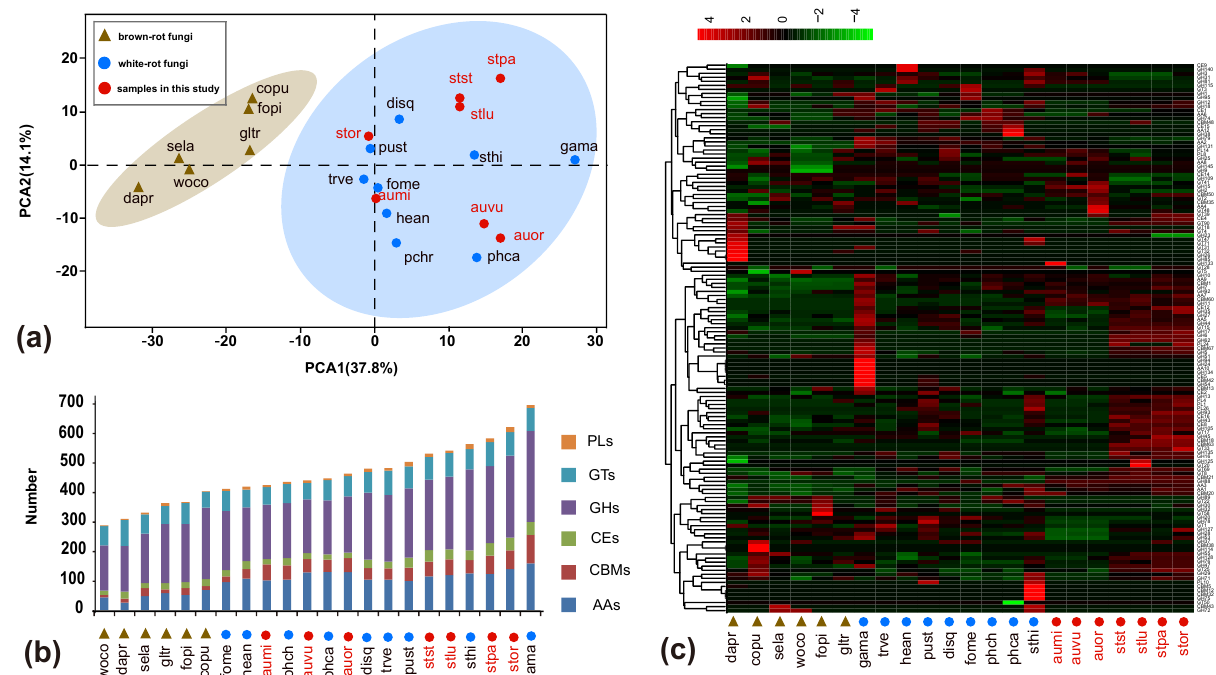
Figure 2. The distributions of genes encoding carbohydrate-active enzymes (CAZymes) in Auriscalpium and Strobilurus fungi. ( a ) wood decay fungi (WDF) plotted on the first two principal components from principal component analyses (PCA) of CAZymes. ( b ) Comparative analyses of CAZymes associated with lignocellulose decomposition. AAs: Auxiliary Activities; CBMs: Carbohydrate-Binding Modules; CEs: Carbohydrate Esterases; GHs: Glycoside Hydrolases; GTs: Glycosyl Transferases; PLs: Polysaccharide Lyases. ( c ) Heatmap analysis of CAZymes showing the distributions of CAZymes among different fungi. Numbers of family members in each genome are demonstrated. Overrepresented (+4 to 0) and underrepresented (0 to − 4) numbers are depicted as scores for each line in heatmap. The clustering on the left involves gene families with the same pattern in number. On the right is the name of the gene